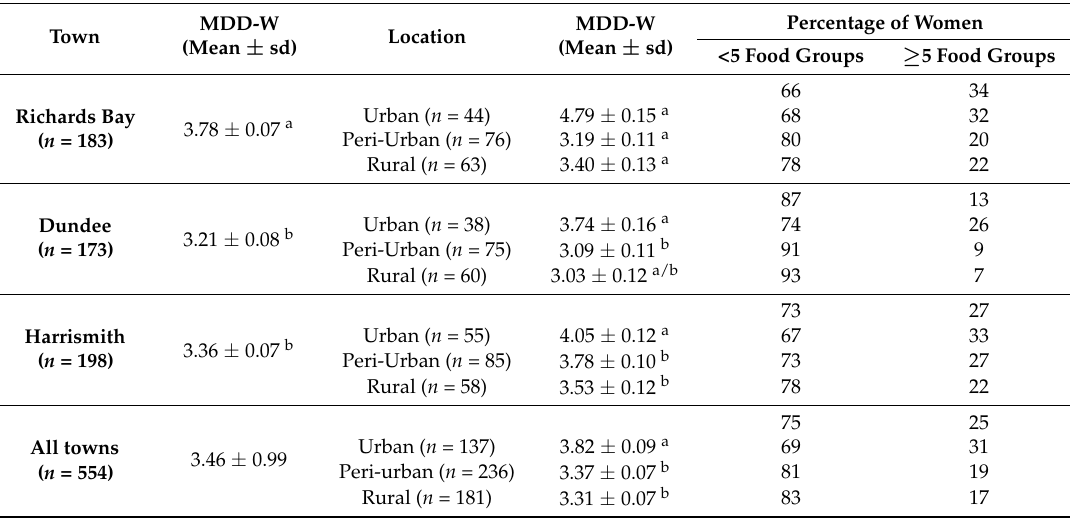
Table 2. Individual dietary diversity scores (MDD-W) of women for three sites and three locations per site. (Unlike superscripts indicate significant differences).